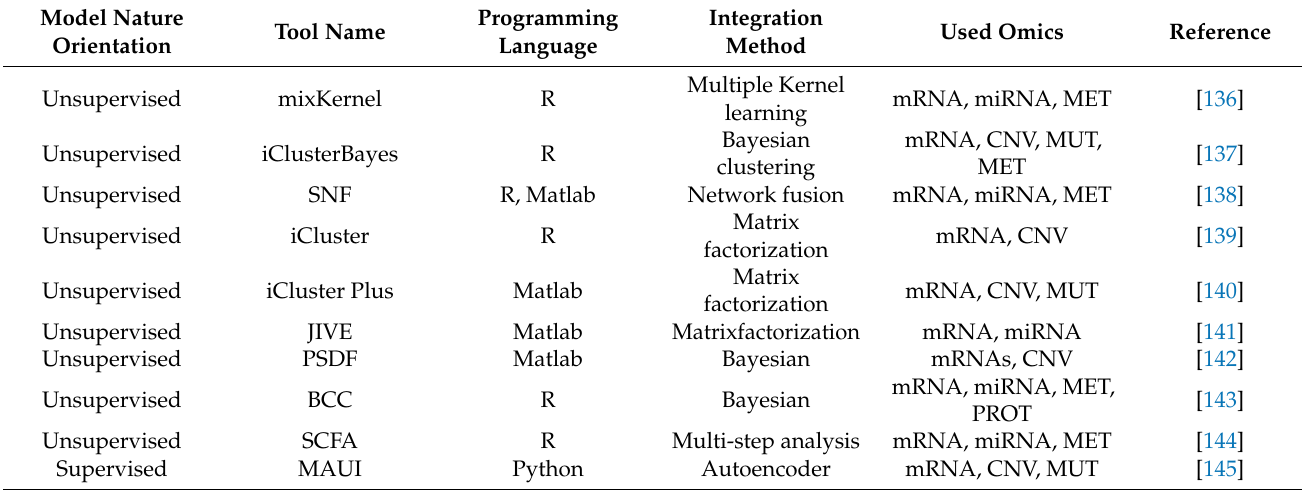
Table 6. Summary of computational tools for Cancer Subtype classification in the field of multi-omics data integration. Model Nature